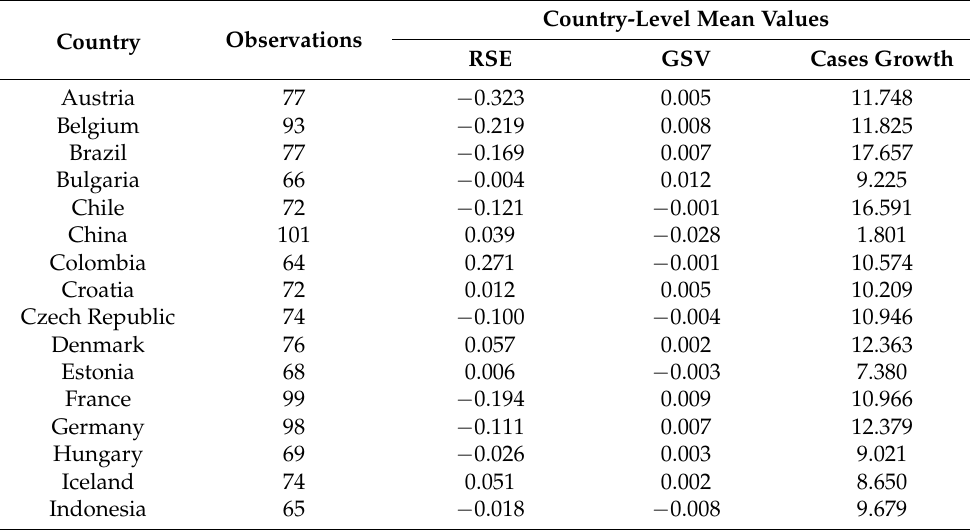
Table A5. Summary statistics for individual